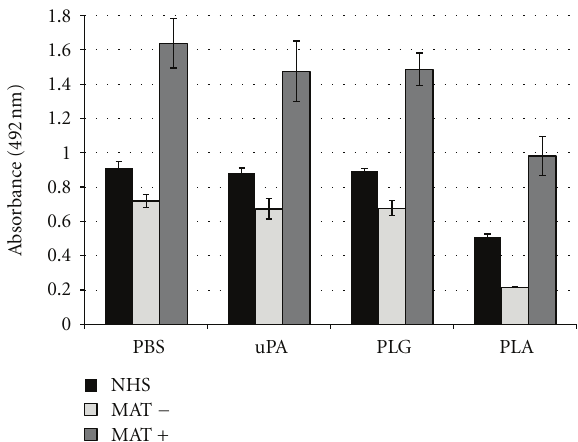
Figure 11: IgG binding from human leptospirosis immune serum to L. interrogans . Bacteria were coated onto microtiter plates (25 × 10 6 leptospires/well) and IgG was bound by incubating bacteria 50% nonimmune human sera (NHS) or confirmed paired leptospirosis patients sera: MAT negative (MAT − ) or MAT positive (MAT+). Bacteria were treated with PBS, 40 μ g/mL PLG (PLG), 5 μ g/mL uPA (uPA), or PLG + uPA (Pla). Presence of human IgG deposited on leptospires was determined by ELISA using Fc-specific anti-human IgG antibodies. Bars represent the mean absorbance values at 492 nm ± the standard deviation of three replicates for each experimental group and are representative of two independent experiments.